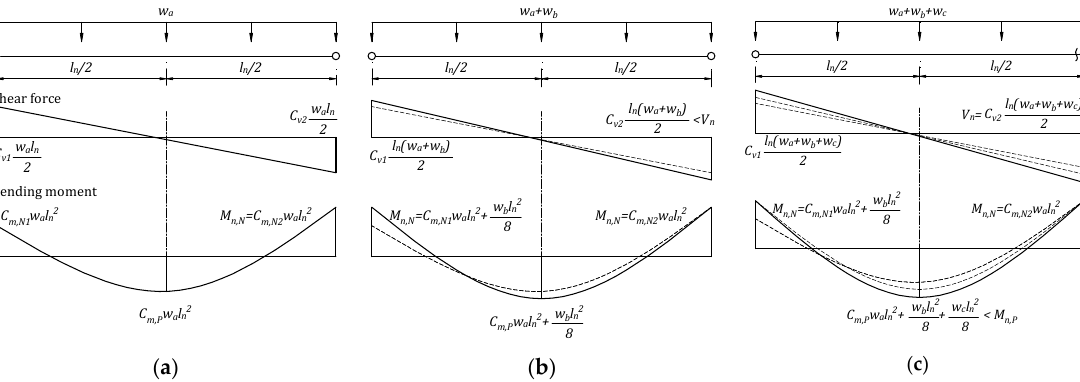
Figure A2. Failure mechanism for DB-1 region. ( a ) Flexural failure at the N2 section first; next, ( b ) flexural failure at the N1 section; and finally, ( c ) shear failure at the N2 section.